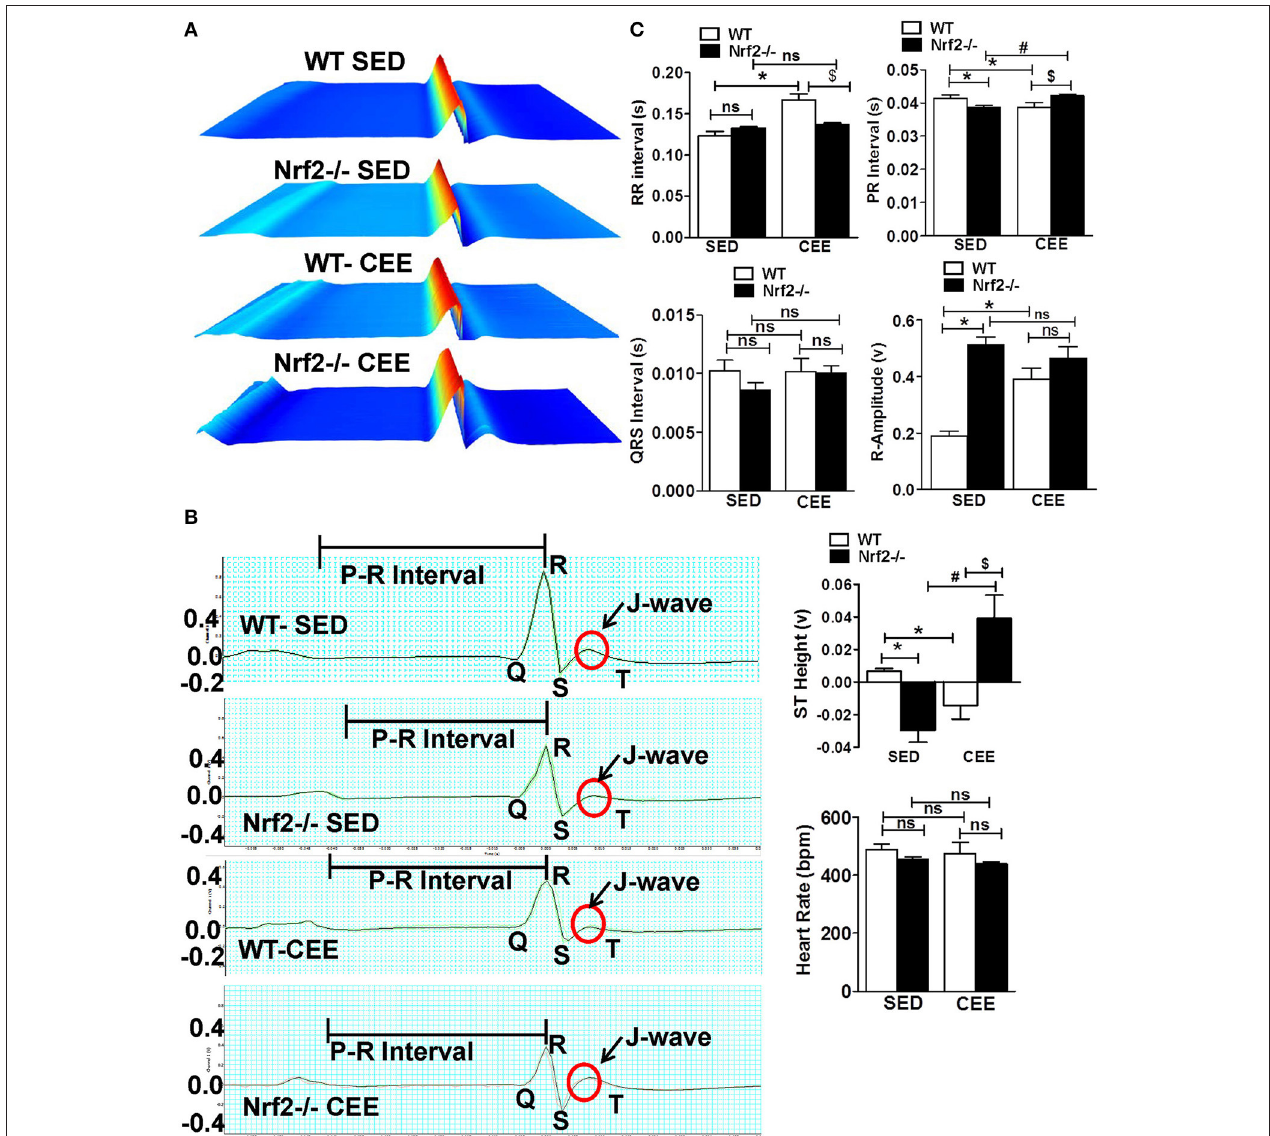
FIGURE 6 | Electrophysiological changes in response to endurance exercise in WT and Nrf2 − / − mice: Electrocardiograms were measured in sedentary and CEE mice for 5-min using iWorx IX/228S data acquisition unit. (A) Waterfall plots displaying changes in ECG traces from 0 to 5 min. (B) A representative electrocardiogram tracings of WT and Nrf2 − / − mice under sedentary and CEE conditions. (C) Quantitative evaluation of PR interval, RR interval, R amplitude, QRS interval, ST height, and heart rate were performed using Labchart 8 pro software in aged WT and Nrf2 − / − mice in response to prolonged endurance exercise. n = 4/group. Histograms show mean ± SD and values with different symbols differ statistically significant with each other at P < 0.05 as assessed by one way ANOVA followed by Tukey multiple comparison tests (* P < 0.05 vs. WT-SED, # P < 0.05 vs. Nrf2 − / − -SED, $ P < 0.05 vs. WT